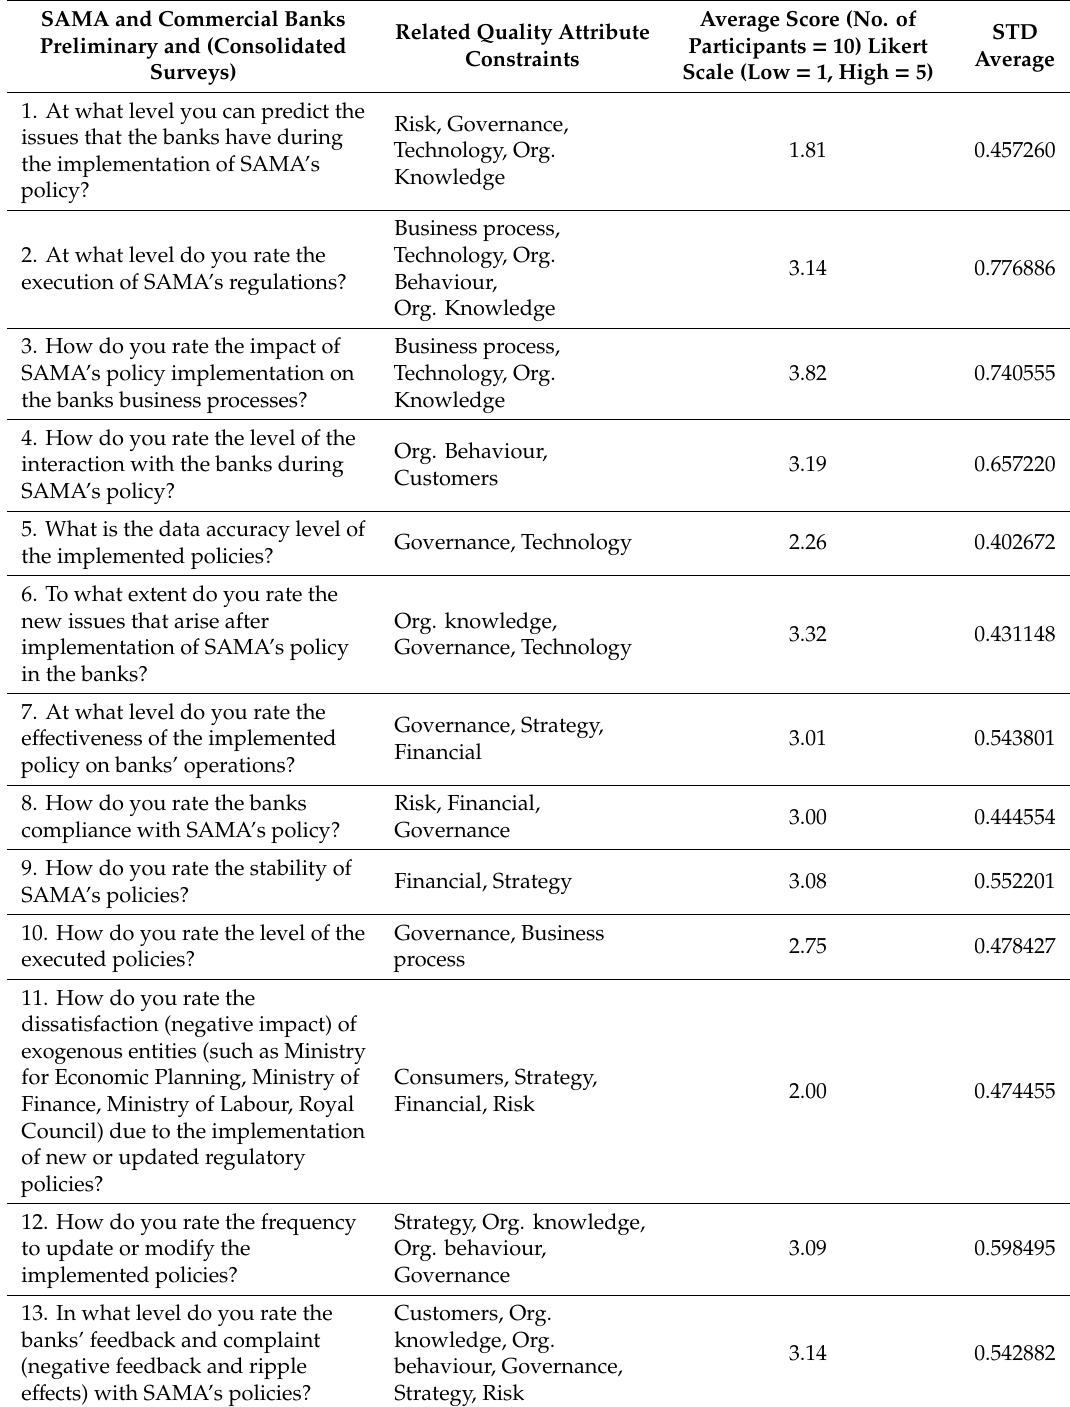
Table A1. Preliminary data and surveys